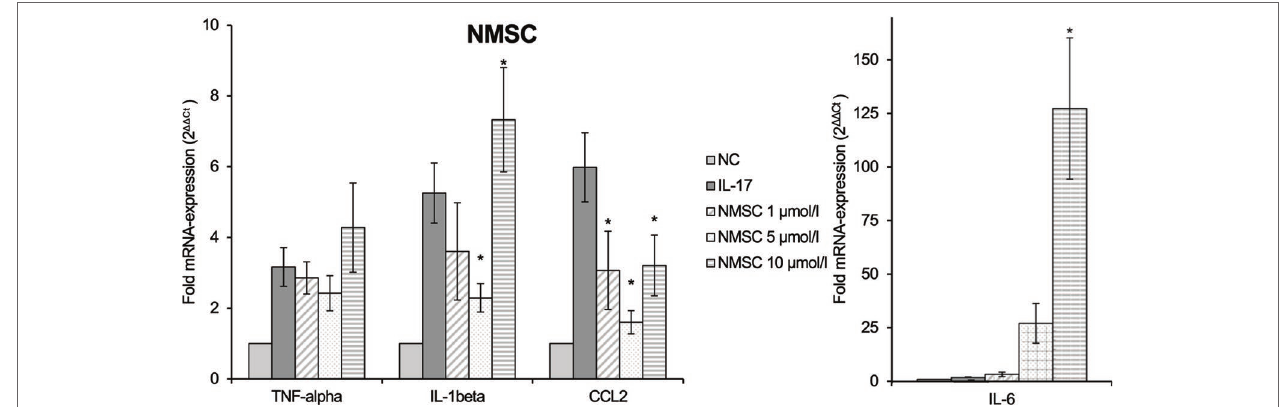
FigURE 9 | Effect of NMSC on the IL‑17‑stimulated mRNA expression of TNF‑ α , IL‑1 β , IL‑6, and CCL2 in RAW264.7 macrophages given as multiples of the reference gene expression. CCL2, CC‑chemokine ligand 2; IL, interleukin; mRNA, messenger RNA; NC, negative control, NMSC; 2‑(methylsulfonamido)ethyl cannabidiolate; TNF, tumor necrosis factor; n = 3 independent experiments; error bars represent SEM, * p < 0.1.